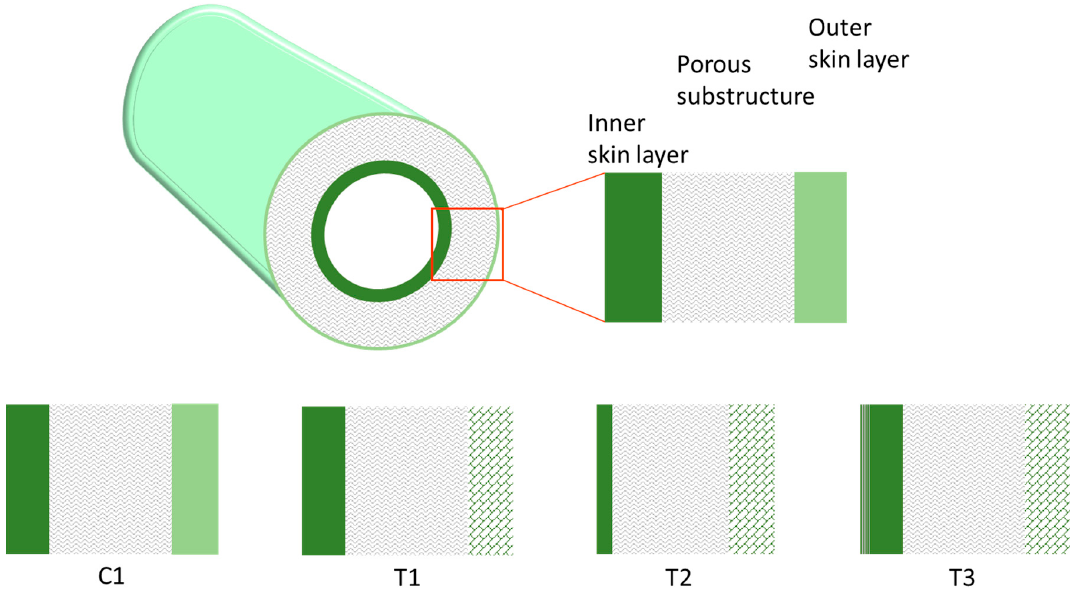
Figure 2. Scheme of the asymmetric structure for the investigated HFs.